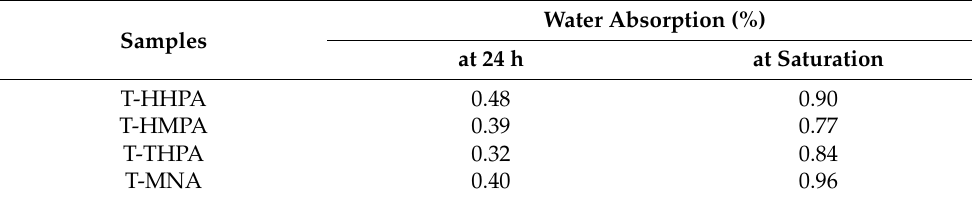
Table 6. Water absorption after 24 h and at saturation for the designed